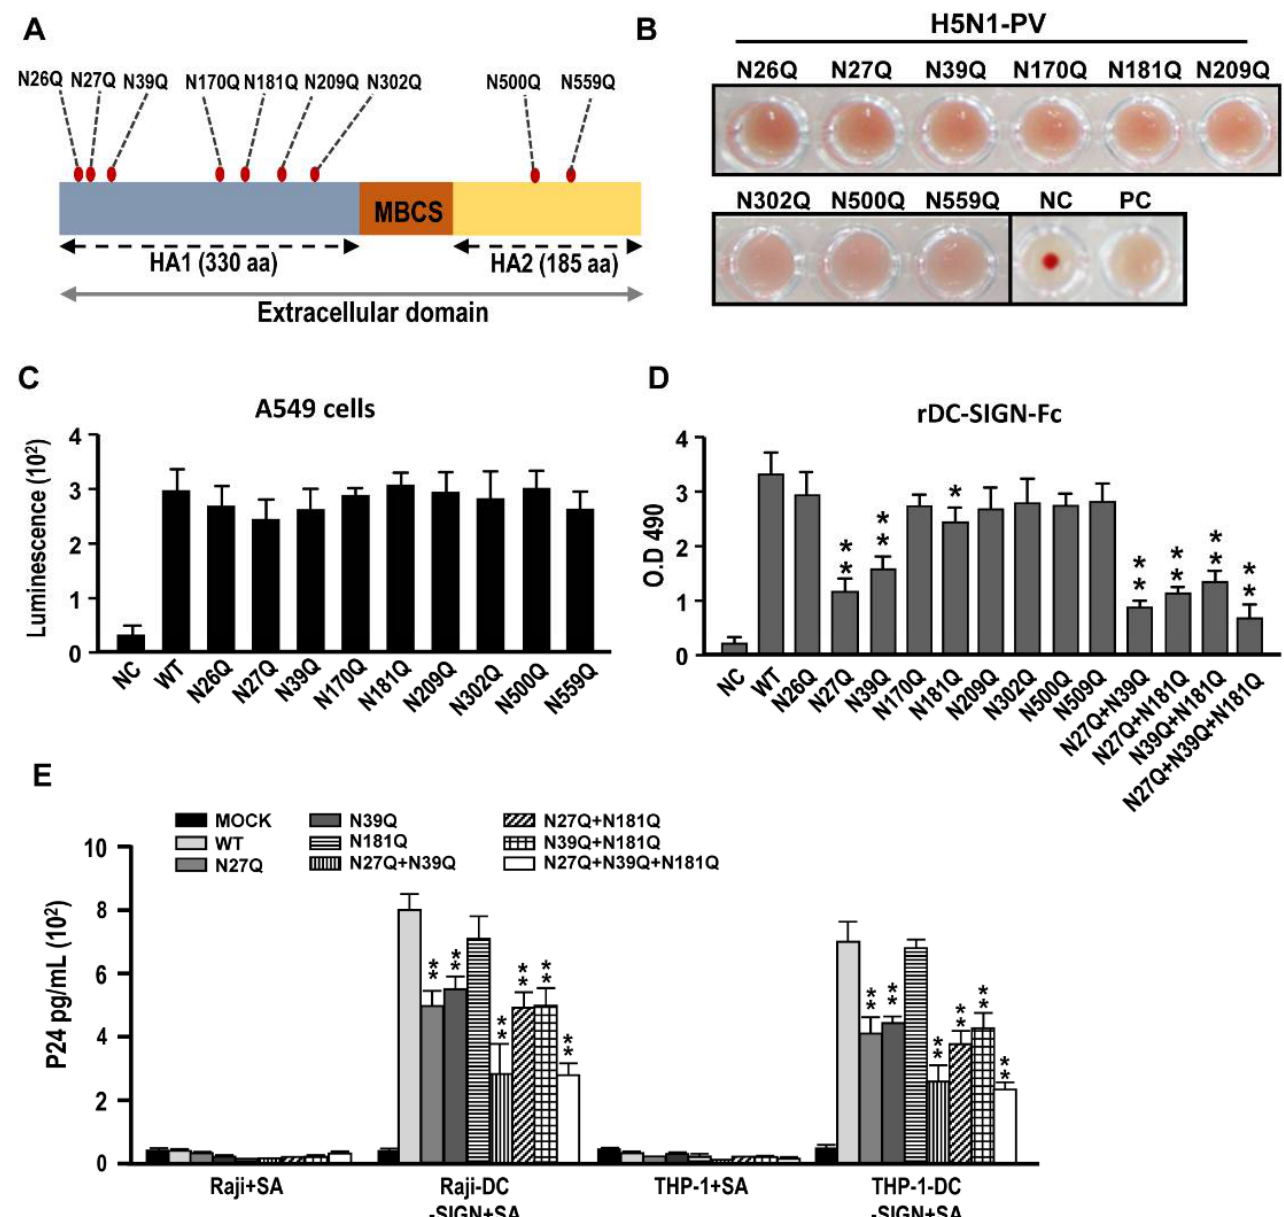
Figure 4. Generation of H5N1-PVs carrying N-glycosylation mutations on HA and evaluation of their infectivity and DC-SIGN interacting abilities. ( A ) The scheme of potential N-glycosylation mutation site on HA are shown. The MBCS indicates “a multi-basic cleavage site.” ( B ) The hemagglutination assay was performed using H5N1-PVs carrying different N-glycosylated mutations and incubated with 0.5% turkey RBC (PC: seasonal H1N1 influenza isolates; NC: PBS). The detail procedure was described in the Materials and Methods. ( C ) Comparison infectivity among the H5N1-PVs carrying different N-glycosylated mutations. ( D ) rDC-SIGN-Fc protein coated ELISA was used to evaluate the binding abilities among the H5N1-PVs carrying different N-glycosylated mutations. ( E ) Sialidase pretreated Raji/Raji-DC-SIGN and THP1-/THP1-DC-SIGN cells were infected with the H5N1-PVs carrying different N-glycosylated mutations. Representative results are shown. Quantitative data represent the means ± SD of results from at least three independent experiments (* p < 0.05; ** p < 0.01).